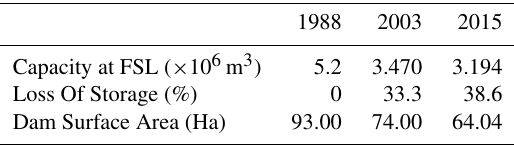
Table 4. Summarized Results from the silt survey.